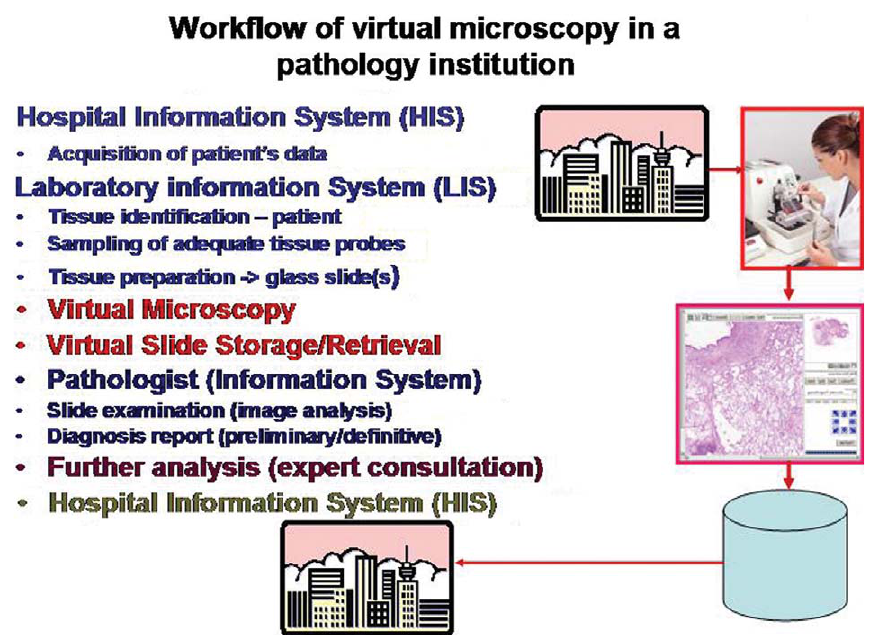
Fig. 2. Workflow of routine diagnostics with included virtual microscopy in an institute of